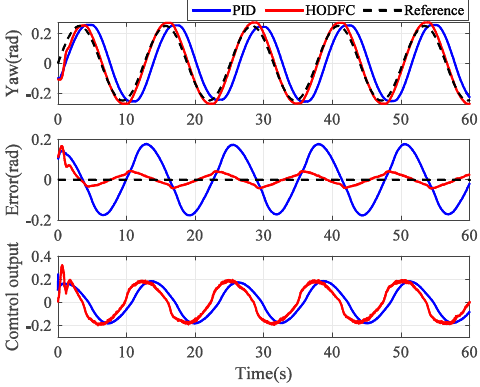
Figure 11. Experimental results of yaw with a sinusoidal function reference.